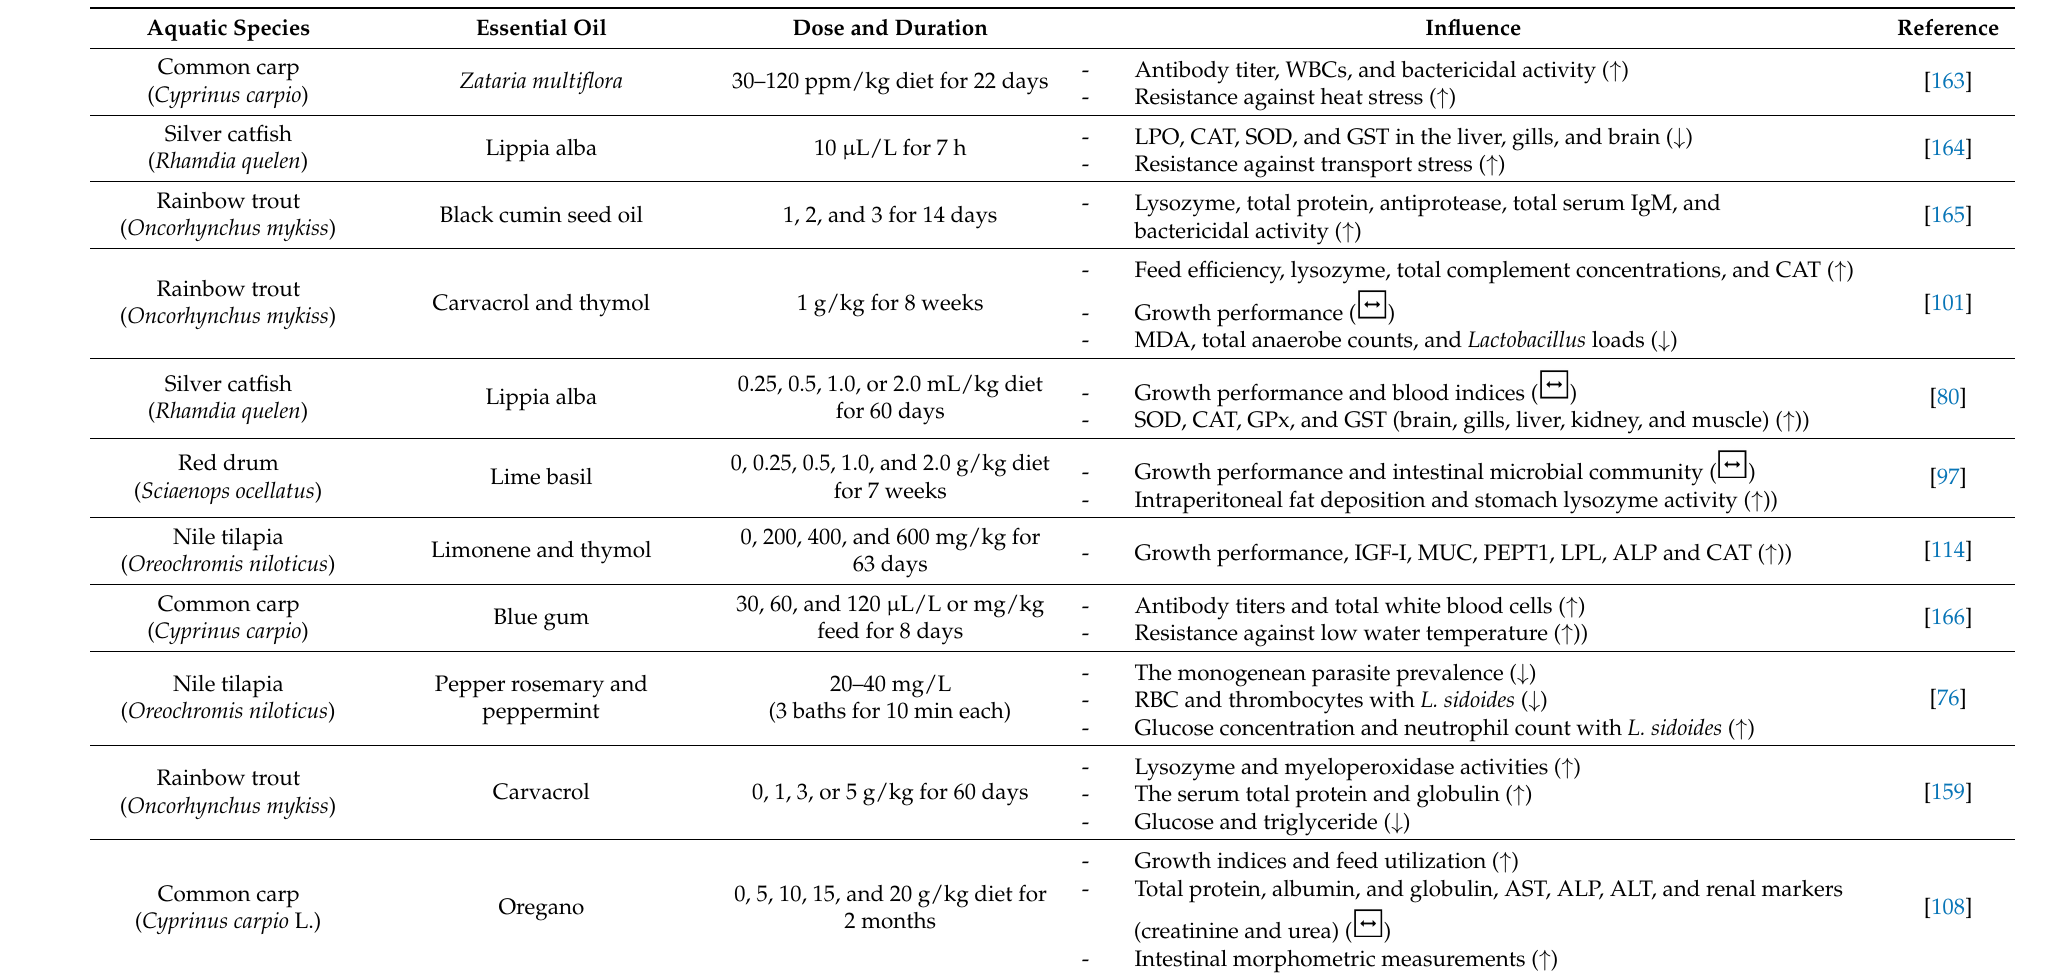
Table 1. Herbal essential oils and their impacts on the physical performances and physiological responses of aquatic